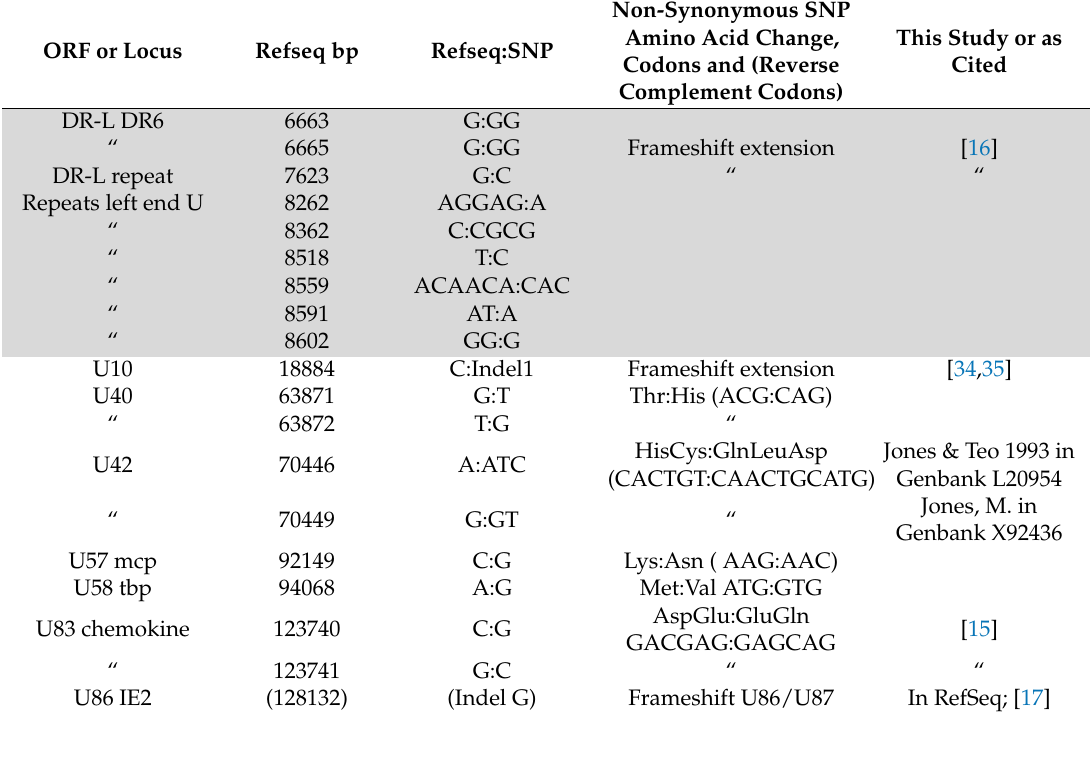
Table 2. Comparison of Illumina resequence human betaherpesvirus 6 (HHV-6A) U1102 to Reference sequence